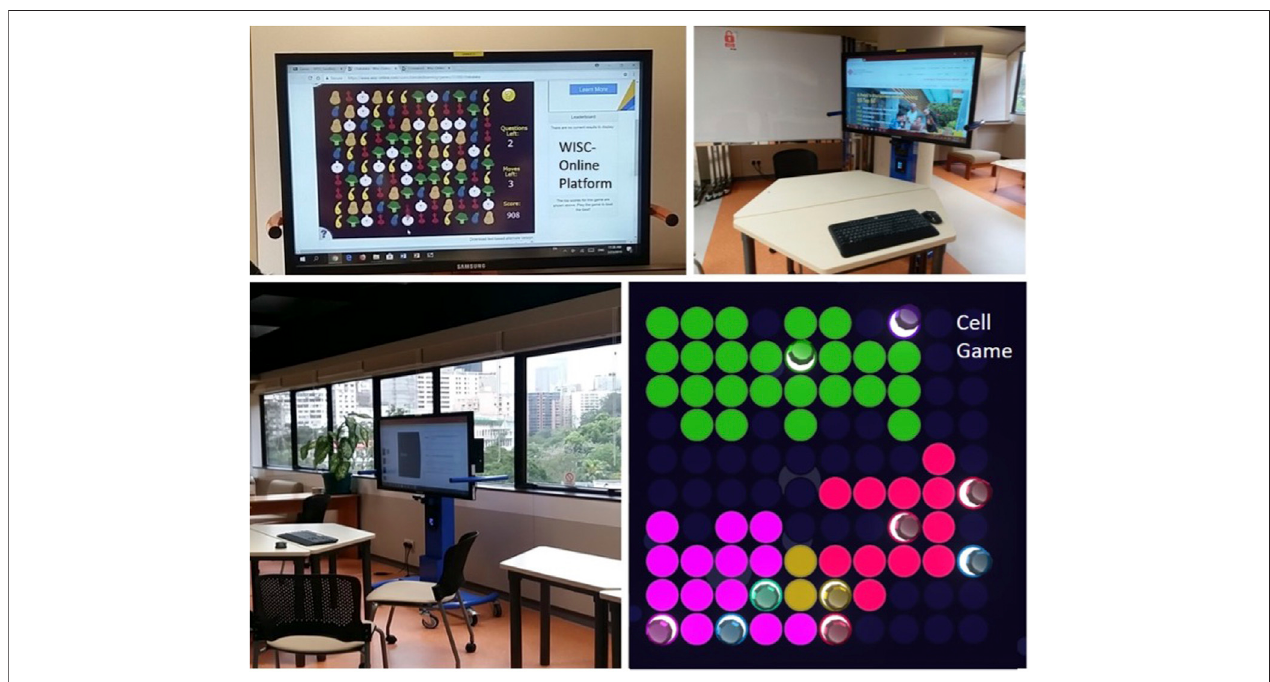
FIGURE 1 | Set up of game-based learning